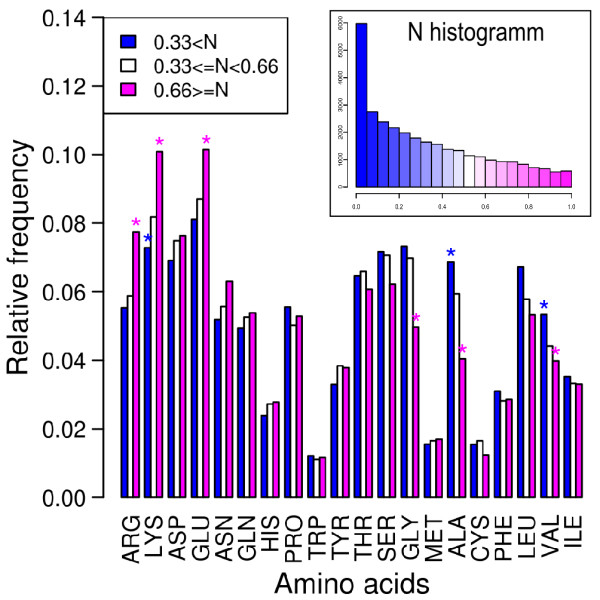
Favored regions are enriched in charged and hydrophilic residues. Amino-acid composition as a function of N, the normalized number of docking hits, for all exposed residues in the target set of 198 proteins after docking with the 314 compact probes. Stars show the cases that make significant a contribution to the Chi-squared test. The right corner inset shows the global distribution of the normalized number of docking hits.